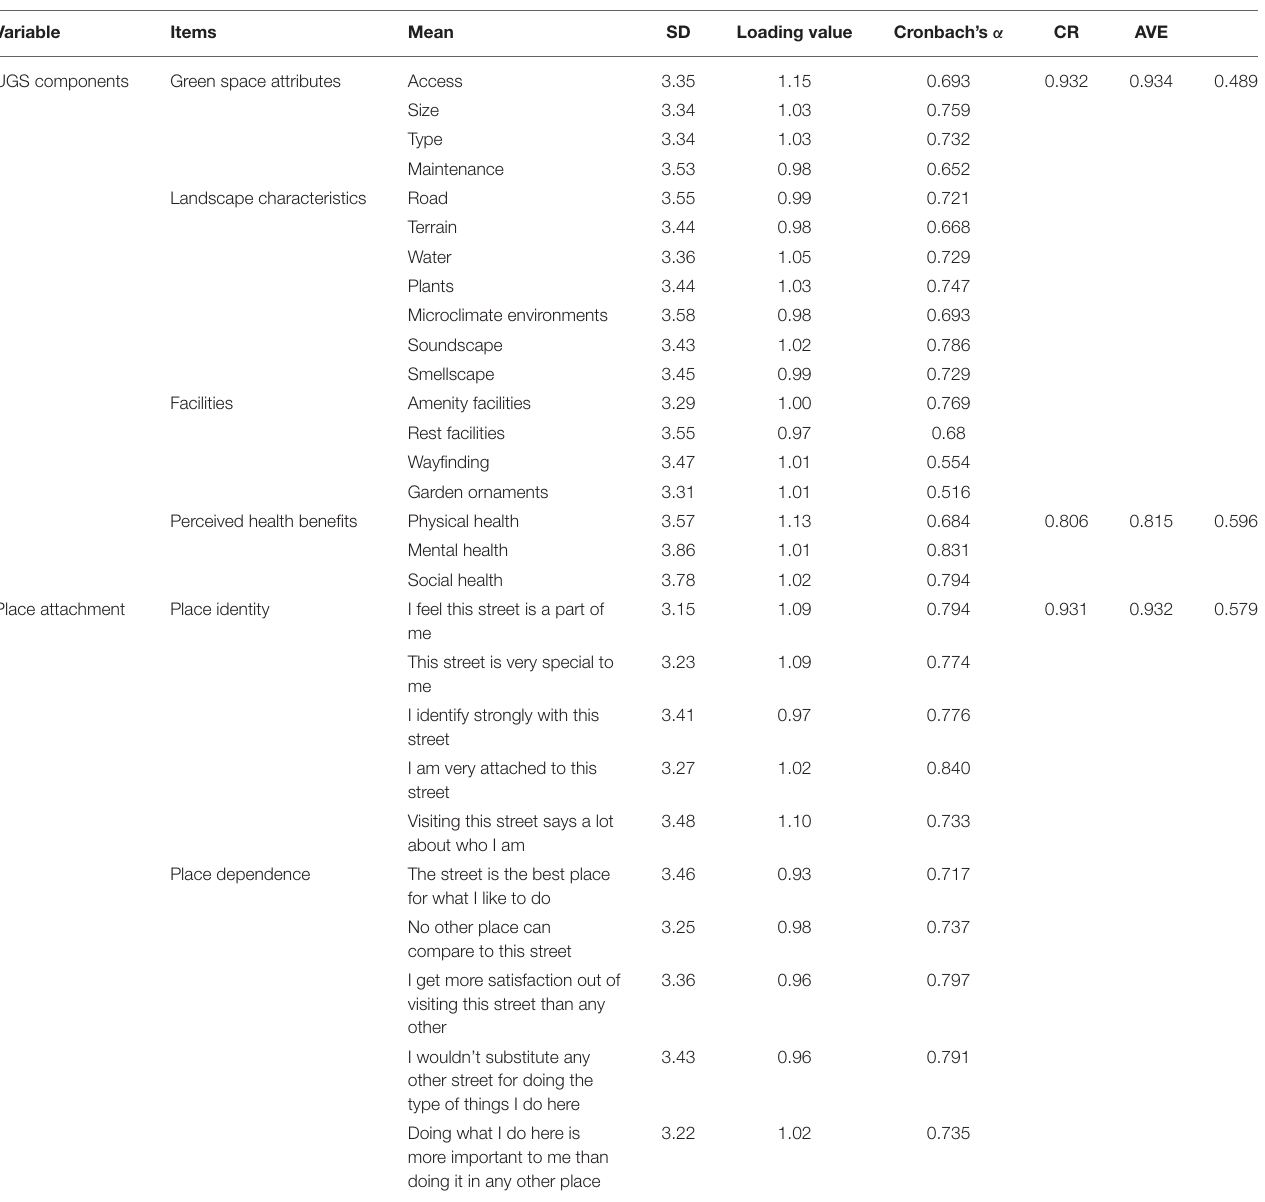
TABLE 2 | Descriptive statistics and reliability and validity analysis.